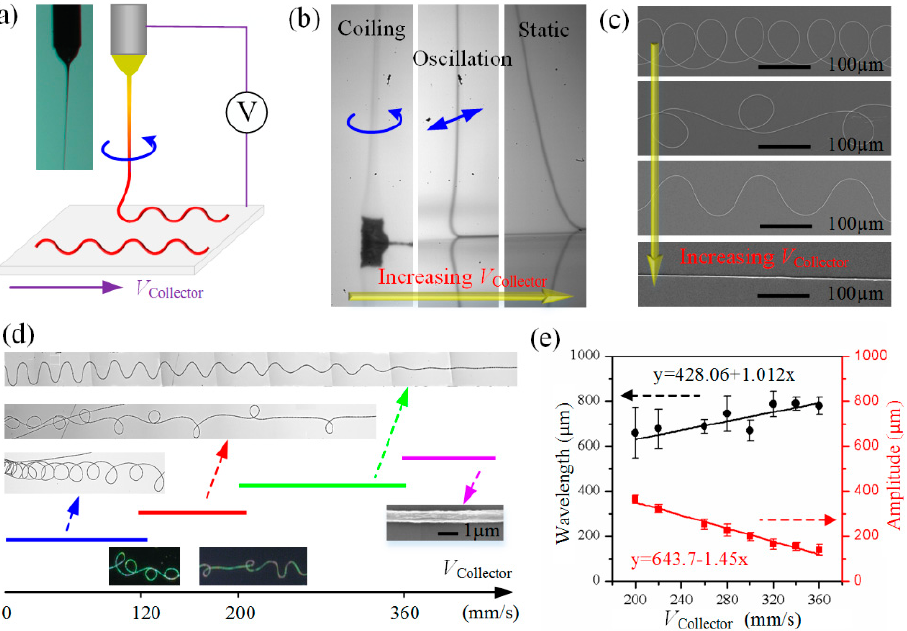
Figure 2. ( a ) The schematic diagram of HE-Printing; ( b ) Optical images of the electrospun jet under different collector velocities; ( c ) SEM images of various patterns direct-written on collector under different collector velocities; ( d ) Patterns deposited on collector when continuously increasing the collector velocity; ( e ) Wavelength/amplitude of serpentine fibers versus collector velocity.